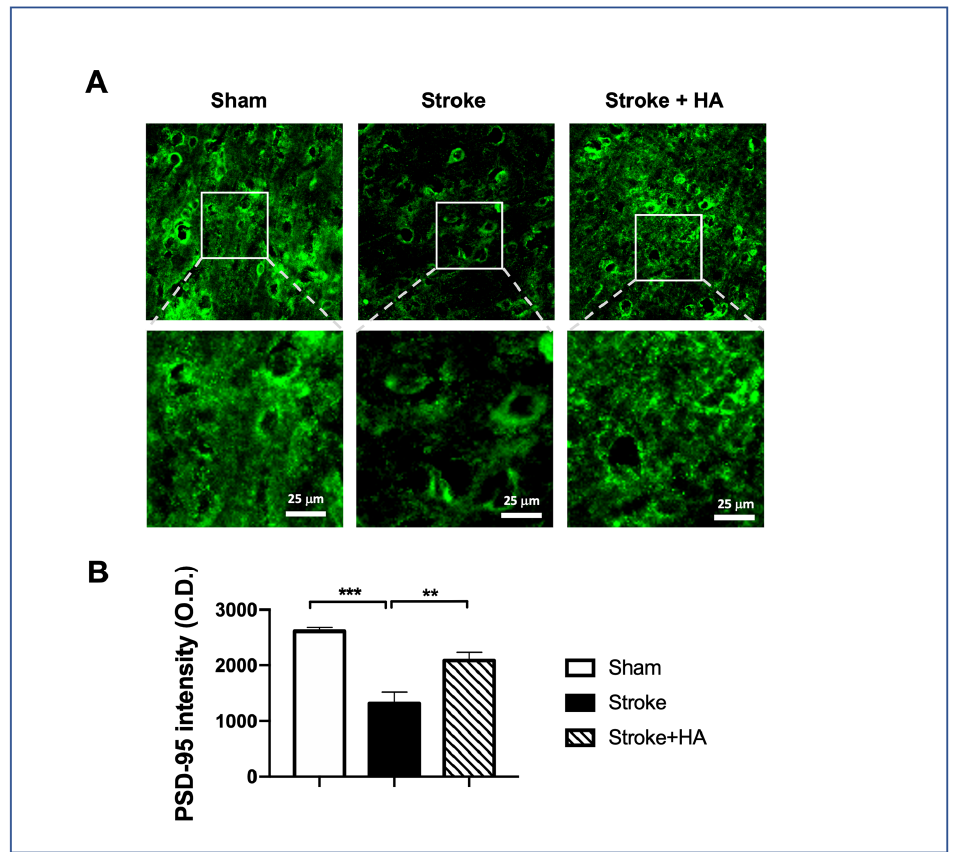
Figure 8 Figure 8. HA treatment improved synaptic density in the rats with cerebral ischemia. ( A ) Represen- tative figures of immunofluorescent staining for PSD95. White boxes noted region with amplification at the lower panel. Data were acquired in the cortex penumbra. ( B ) Quantification of PSD95 immunoreactive density. n = 6 per group. ** Denotes p < 0.01, *** denotes p <